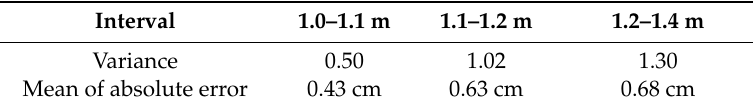
Table 1. Variance and mean of the absolute error of different intervals.